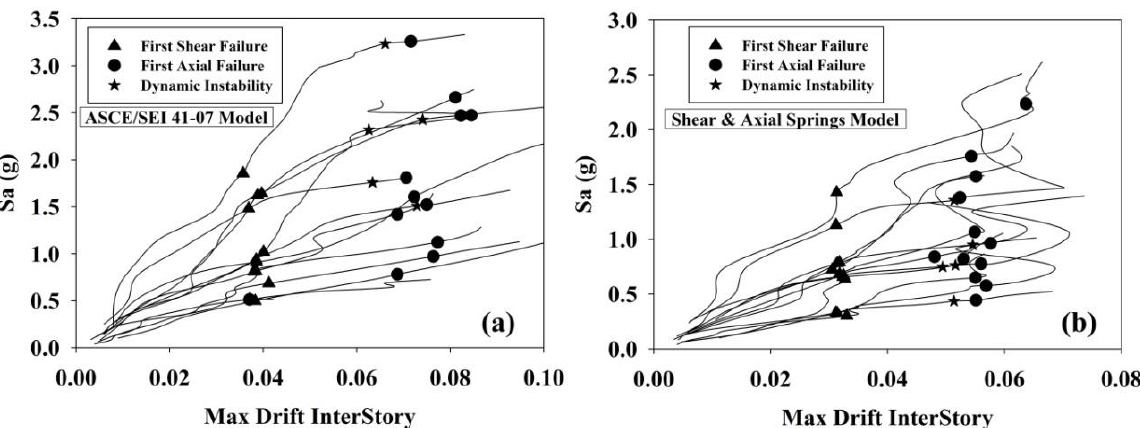
Fig. 11. Sa (g) Vs. Maximum Inter-story drift ratio for 3-Story model with P/Ag.f’c =0.12, S=200 mm. a) ASCE/SEI 41-13 modeling approach, b) shear and axial springs modeling approach.